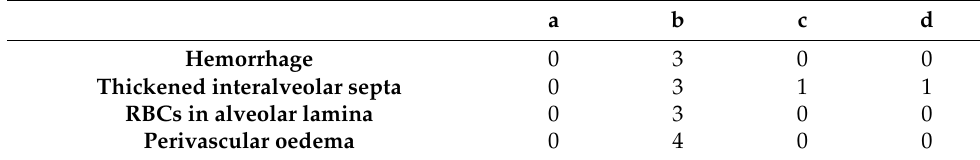
Table 5. Scoring of pulmonary lesions.